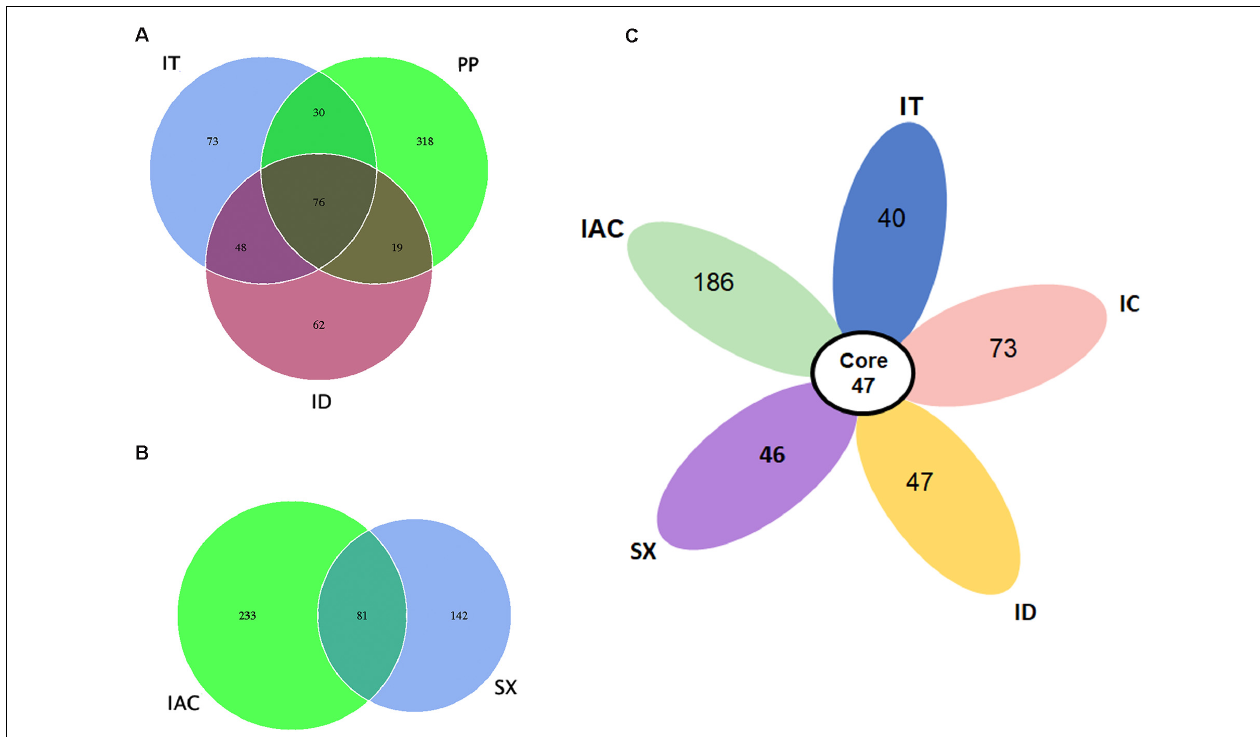
FIGURE 4 | Core gut mycobiome. (A) Venn diagram showing the gut fungal OTU distribution between the spruce feeding bark beetles (IT, PP, and ID) where the number of OTUs (common or unique) shared among the beetles is denoted. (B) Venn diagram displaying the number of common and unique OTUs between the pine feeding beetles (IAC and SX). (C) Flower diagram showing the presence of 47 core OTUs shared among the five different Ips bark